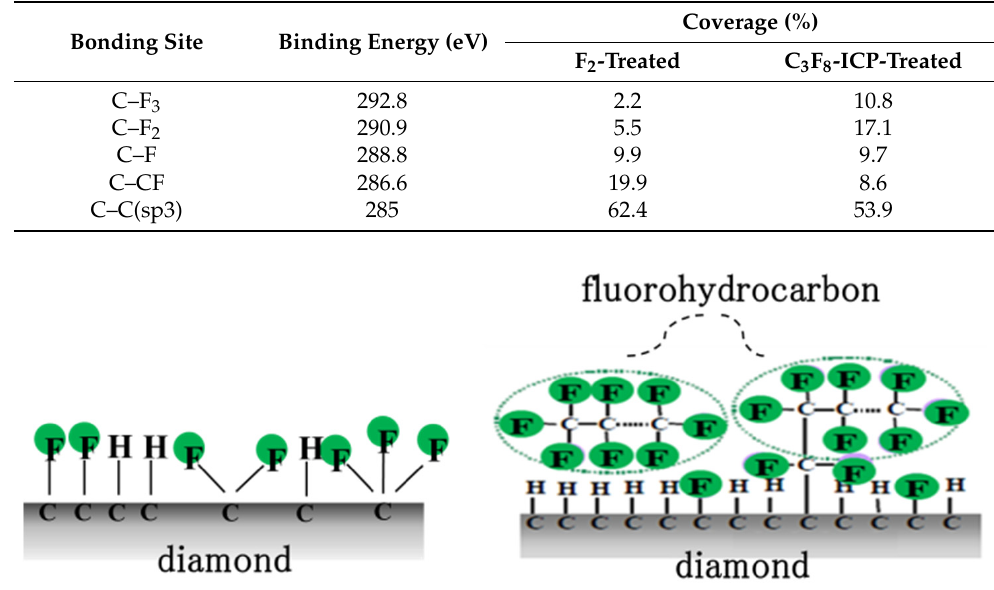
Table 1. Quantification of the bonding state of fluorine functional groups on the C–F diamond surface.